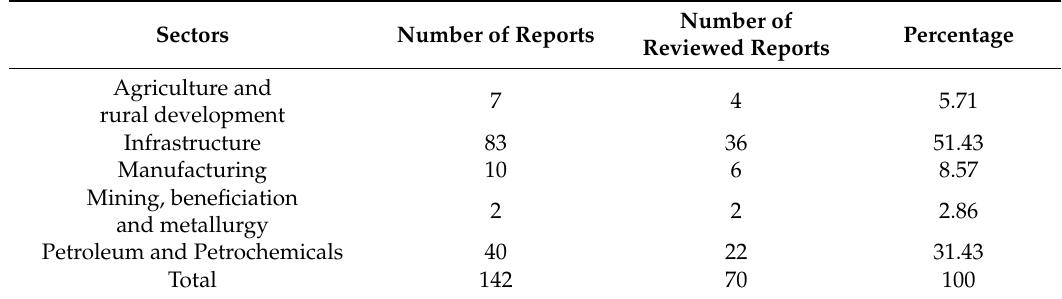
Table 7. Sectorial distribution of reviewed Niger Delta EIA reports.